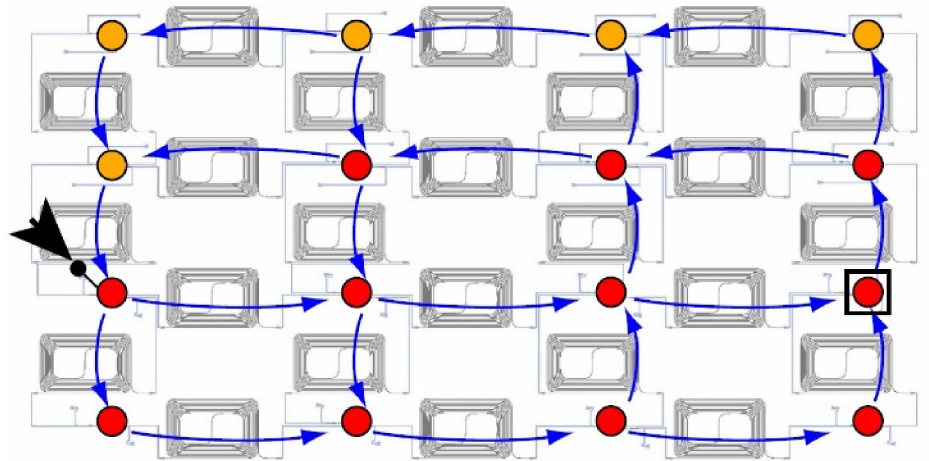
Figure 11. The reservoir structure in optical materialization (chip). It is consisted of interferometers for coupling and splitting between the nodes. Blue arrows represent the specific light flow, if for input is used the node indicated with black arrow. Nodes with yellow dots have output powers below the noise floor. Red ones have an amplitude above noise floor and were measured and used for offline training. For testing the device, an example waveform with sequences of bits with “1” and “0” were collected in the black square with a rounded red dot [50].